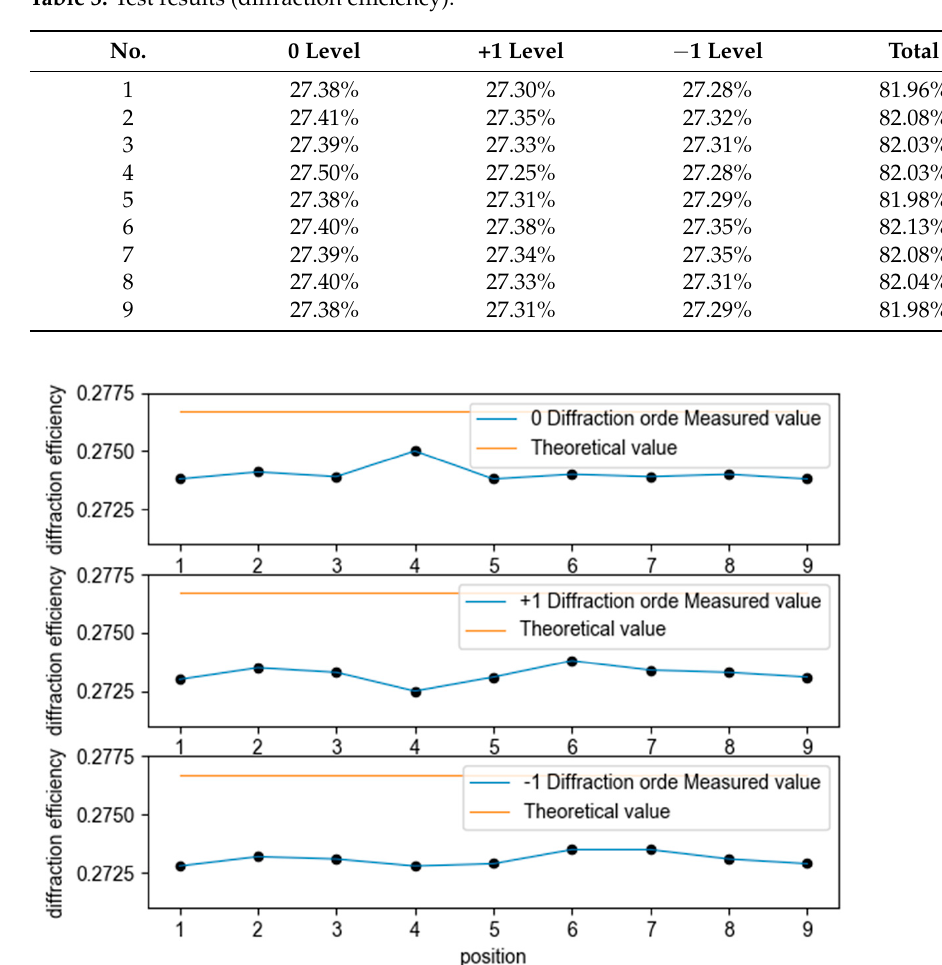
Figure 12. Comparison of theoretical and measured values of diffraction efficiency for different diffraction stages.